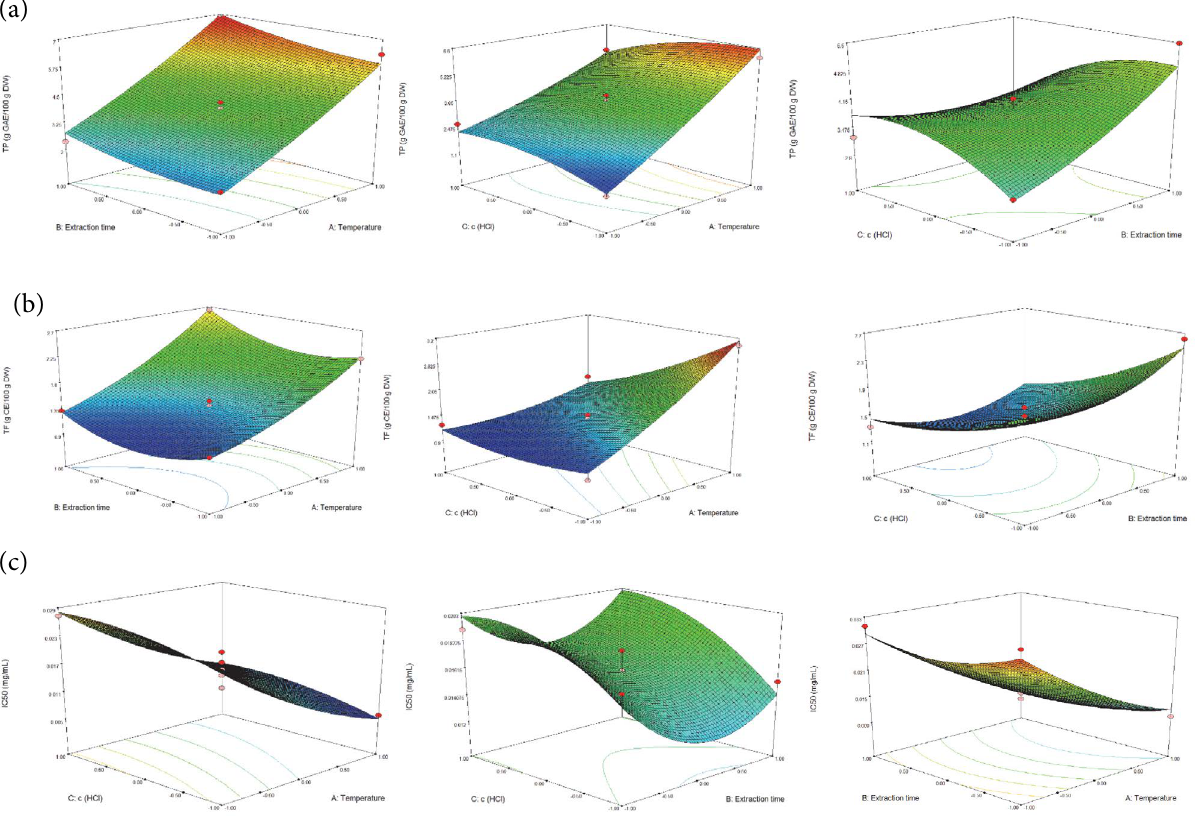
Figure 1. Response surface of TP content (a), TF content (b) and IC 50 value (c) as simultaneous function of temperature, extraction time and HCl